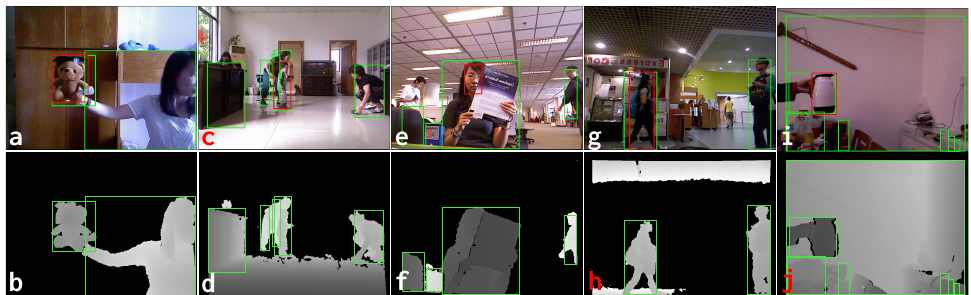
Figure 18. RGB and corresponding depth snapshots of from the PTB data set [1]. ( a , b ): bear_front, ( c , d ): child_no1, ( e , f ): face_occ5, ( g , h ): new_ex_occ4, and ( i , j ): zcup_move_1. The RGB images show our obstacle estimation in green rectangular boxes, and the ground truth annotations are in red rectangular boxes.